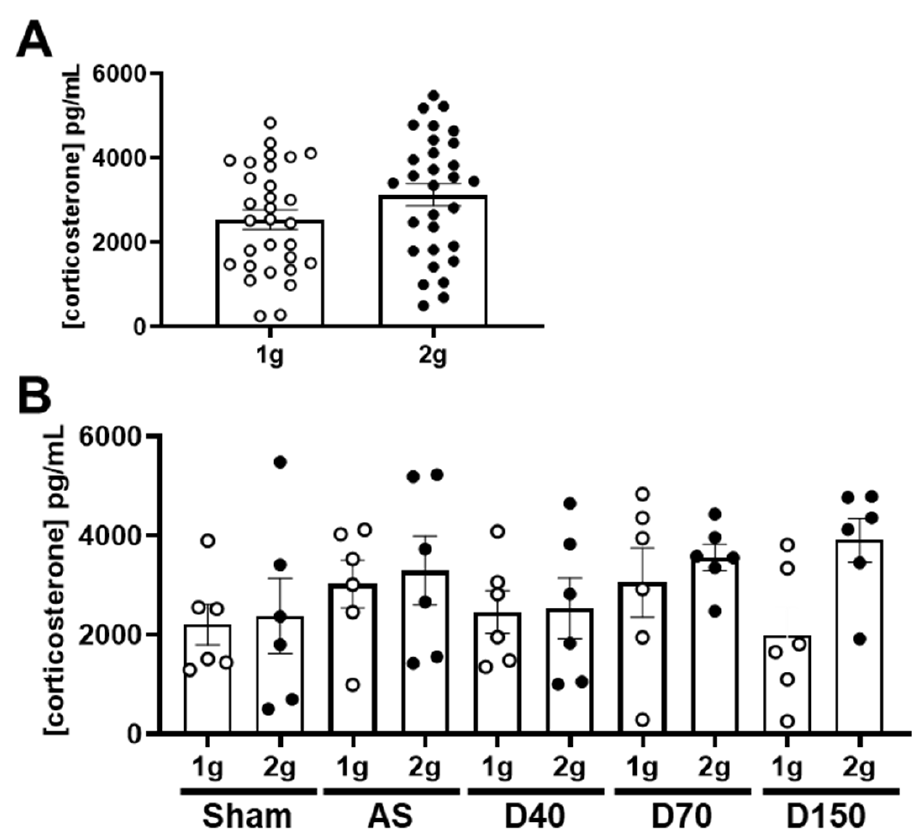
Figure 2. Effects of centrifugation on corticosterone concentration. ( A ) Corticosterone concentration (in pg/mL) in both normogravity (1 g, circle) and hypergravity (2 g, point) conditions (n = 30 per conditions). ( B ) Corticosterone concentration (in pg/mL) in both normogravity (1 g) and hypergravity (2 g) conditions in Sham-, AS-, D40-, D70- and D150-injected mice (n = 6 per conditions).